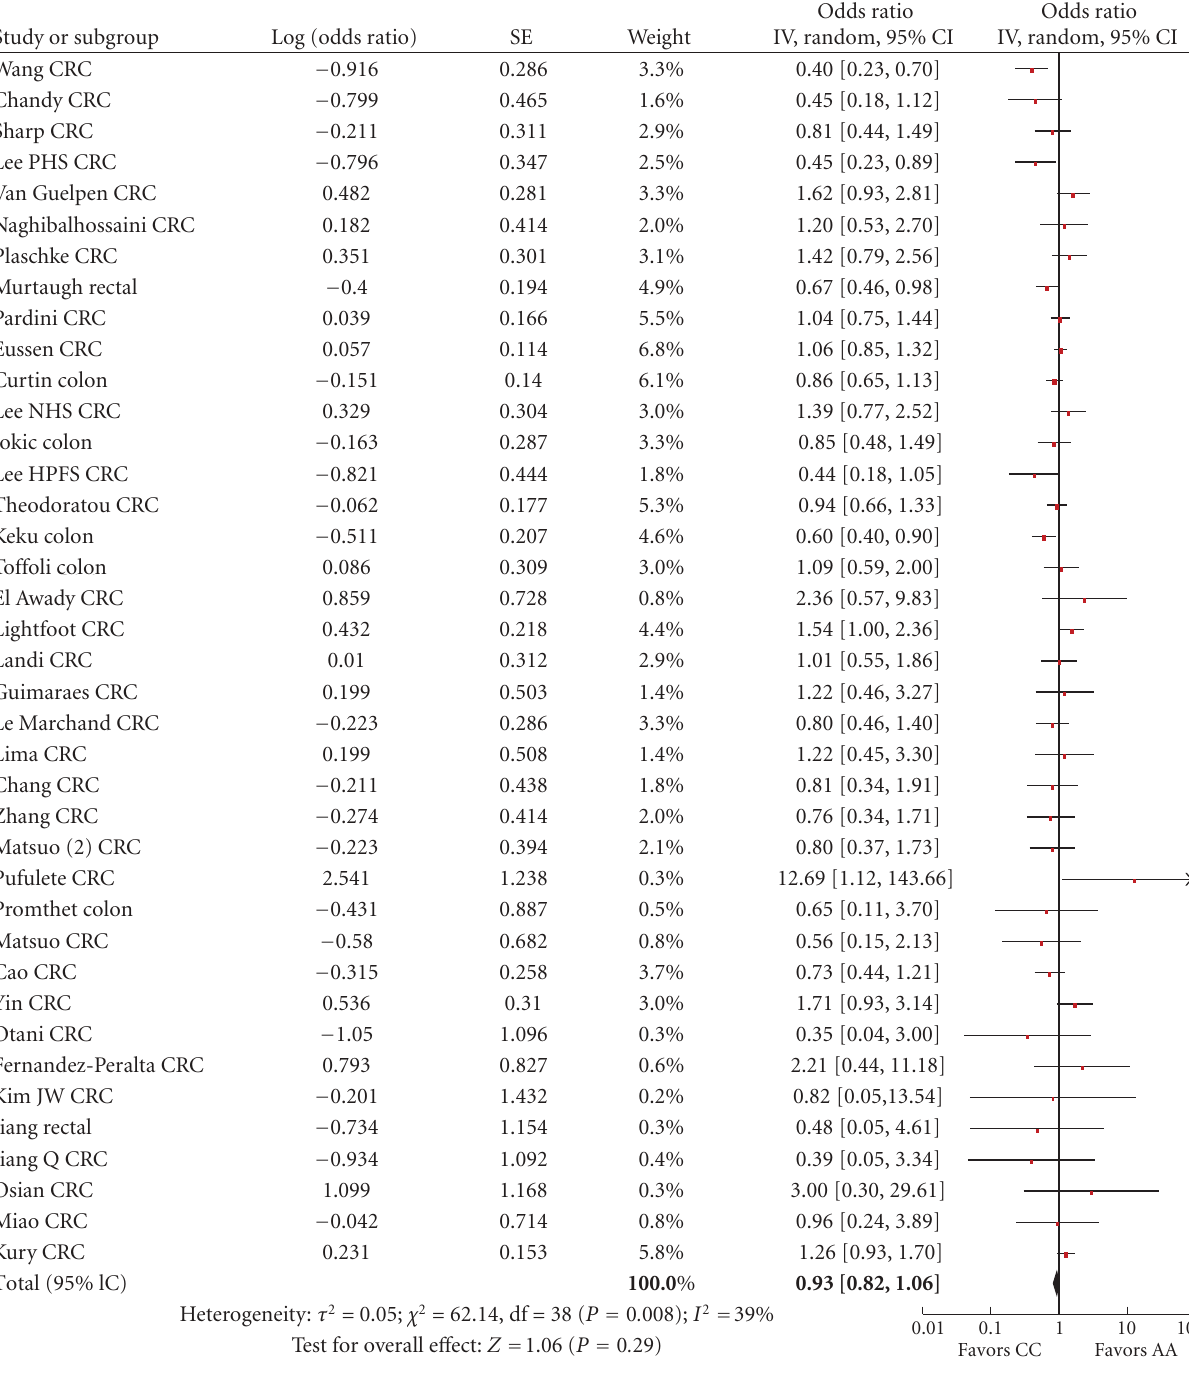
Figure 5: Forest plot of the risk of colorectal cancer for MTHFR 1298 CC versus